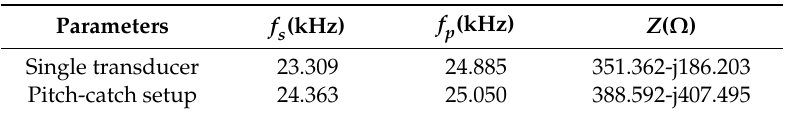
Table 1. The electrical impedance at resonance and anti-resonance frequencies of the single sandwiched piezoelectric ultrasonic transducer and the pitch-catch